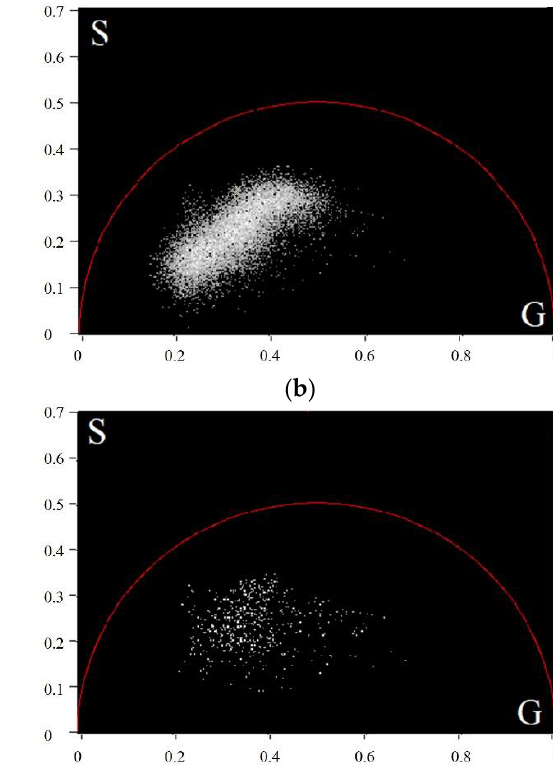
Figure 4. The results of the average TPAF lifetime t m image of exosome samples processed by a cutting filter: the image for the CRC patient ( a ) and the image the CP patient ( b ). The cutting filter had a threshold of 800 photons per pixel. The corresponding unprocessed images are presented in Figure 2. The results of the cutting filter application presented in a phasor plane are shown in Figure 5.